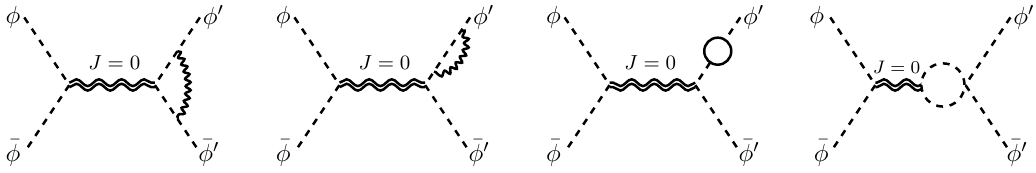
Figure 6 . Feynman diagrams of class (B) that “survive” the cancellation. They are all proportional to the J = 0 component of the gravity mediated amplitude A min (1 φ , 2 ¯ terms proportional to the J = 2 component of A min cancel among themselves, as we explain in appendix